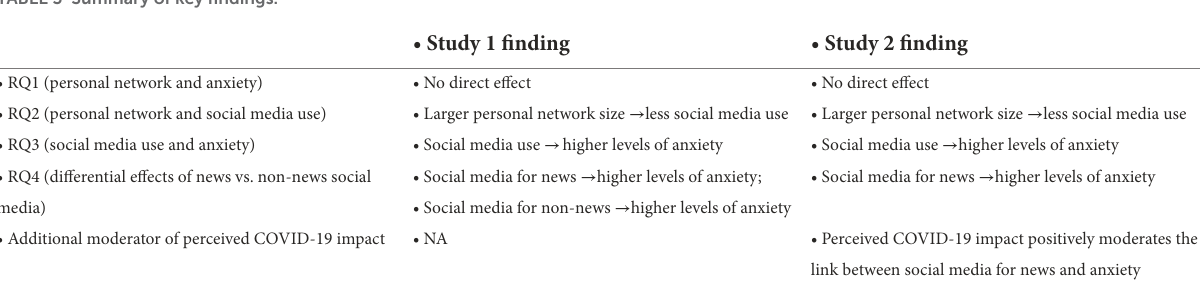
TABLE 3 Summary of key findings.